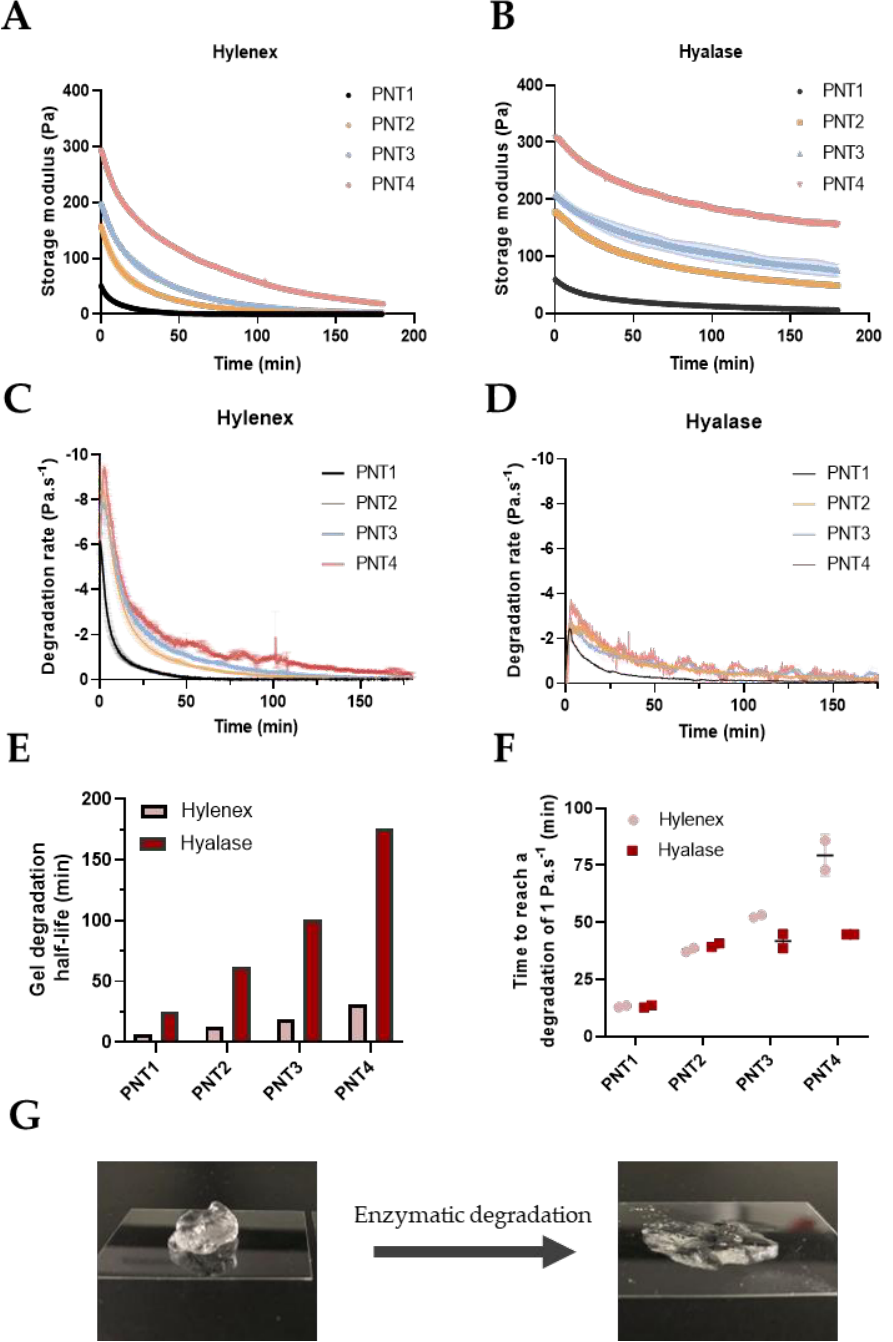
Figure 1. Degradation of Teosyal PNT gels in contact with Hylenex or Hyalase for 180 min, assessed by rheological time sweeps (37 °C, strain 0.1%, 1 Hz). ( A ) Degradation of PNT gels in contact with 7.1 U·mL − 1 of Hylenex over a 3-h period, ( B ) Degradation of PNT gels in contact with 7.1 U·mL − 1 of Hyalase over a 3-h period, degradation rates of Hylenex-treated ( C ) and Hyalase-treated ( D ) PNT gels calculated from the first derivatives, ( E ) time required to reach 50% of gel degradation (half-life) of PNT gels with Hylenex or Hyalase enzymes, ( F ) time needed to reach an enzymatic degradation speed inferior to 1 Pa·s − 1 , ( G ) example of a PNT4 gel before (left) and after (right) treatment with the Hylenex enzyme. All results are presented as mean ± S.D, n = 2.